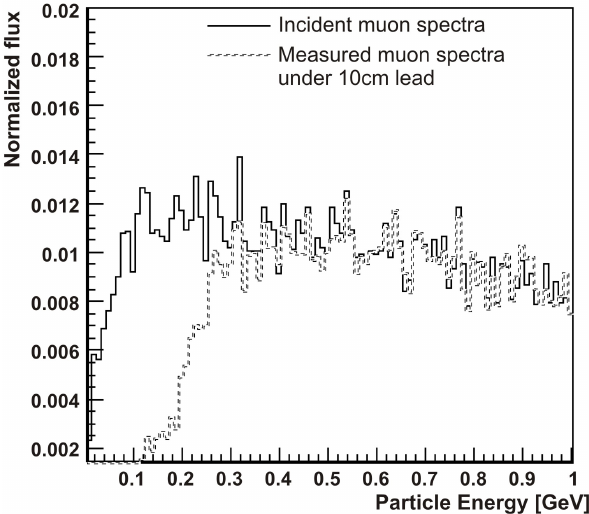
Fig. 7. The energy spectra of muons registered in the upper and bottom 5-cm thick scintillators. The energy threshold of the upper scintillator is ∼ 7MeV, bottom – ∼ 250MeV.